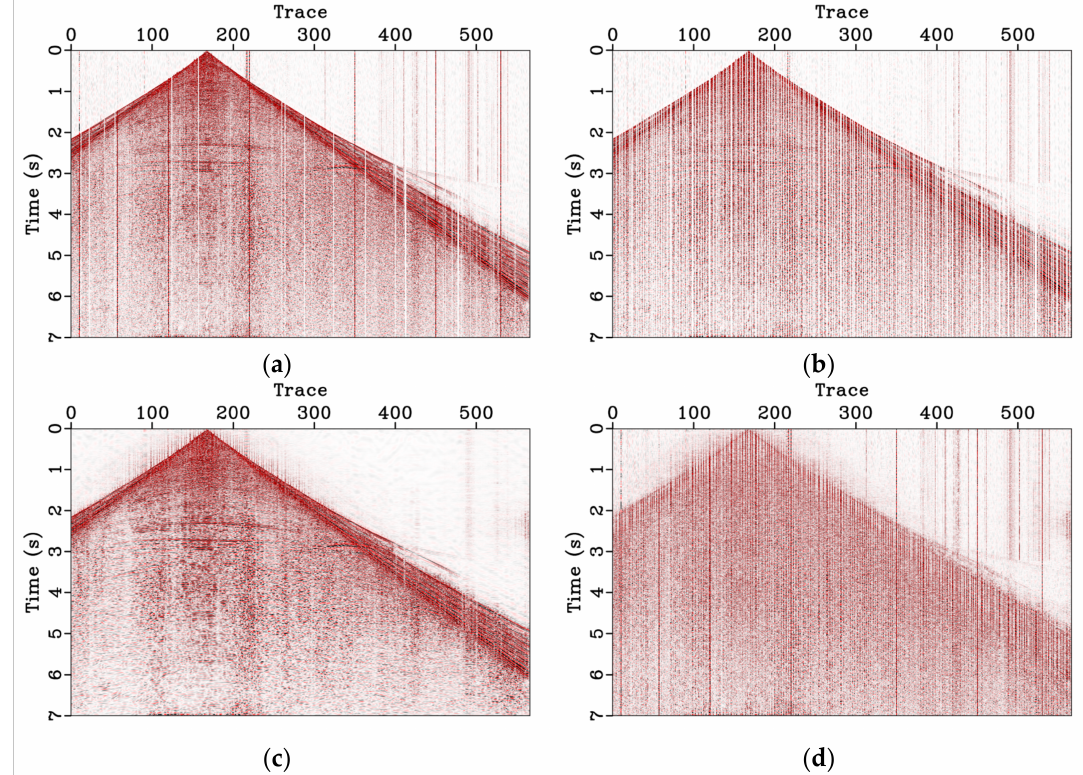
Figure 18. Land field data of denoising performance. ( a ) Raw noisy data. ( b ) The 30% jittered undersampling with outlier noise. ( c ) The denoising results. ( d ) Difference